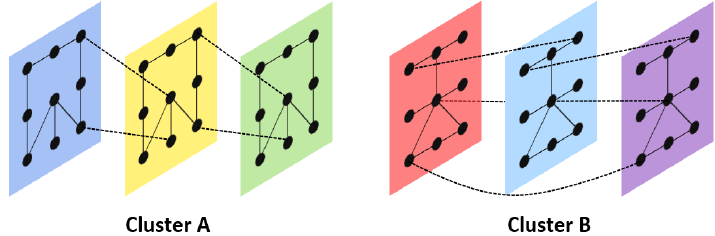
Figure 9. Exemplary MRF structures for two distinct clusters based on [3].